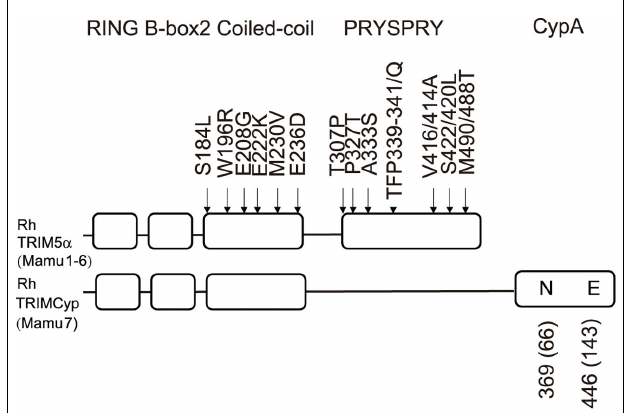
FIGURE 2 | Domains of rhesus monkey (Rh)TRIM5 α andTRIMCyp proteins. The RING, B-box2, Coiled-coil, PRYSPRY, or CypA domains of Rh-TRIM5 α andTRIMCyp are shown by squares. Polymorphisms are shown outside the squares.The numbers in parentheses show the amino acid positions counting from the initiation methionine codon of the CypA open reading frame.